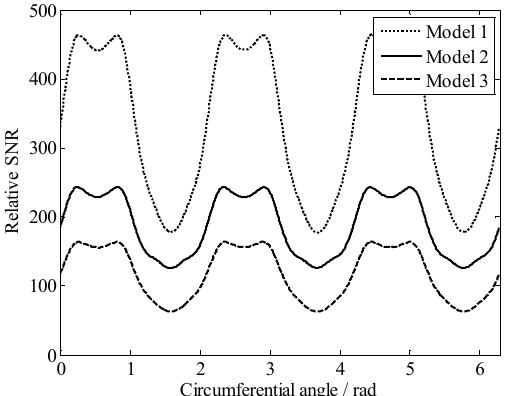
Figure 6. Relative SNRs of the RF coils with different structure parameters, where, parameters of Model 1 are N = 4, L = 28 mm, h =15.2 mm, w = 0.8 mm, d 1 = 2 mm, and d 2 = 1.2 mm; parameters of Model 2 are N = 6, L = 32.3 mm, h =15.2 mm, w = 0.6 mm, d 1 = 1.5 mm, and d 2 = 0.9 mm; and parameters of Model 3 are N = 6, L = 34.3 mm, h =15.2 mm, w = 0.6 mm, d 1 = 1.5 mm, and d 2 = 0.9 mm.